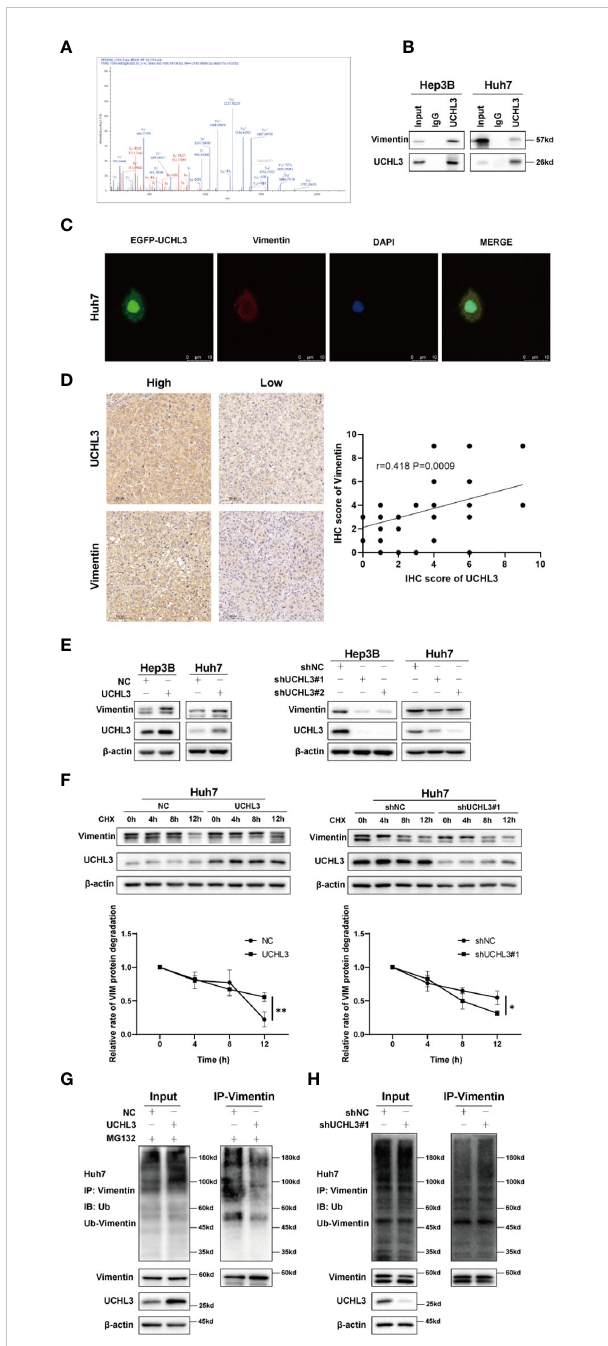
FIGURE 4 UCHL3 de-ubiquitinylated and stabilized Vimentin. (A) Mass spectrometry showed that the UCHL3-binding complex contained Vimentin peptide fragments. (B) Co-immunoprecipitation with